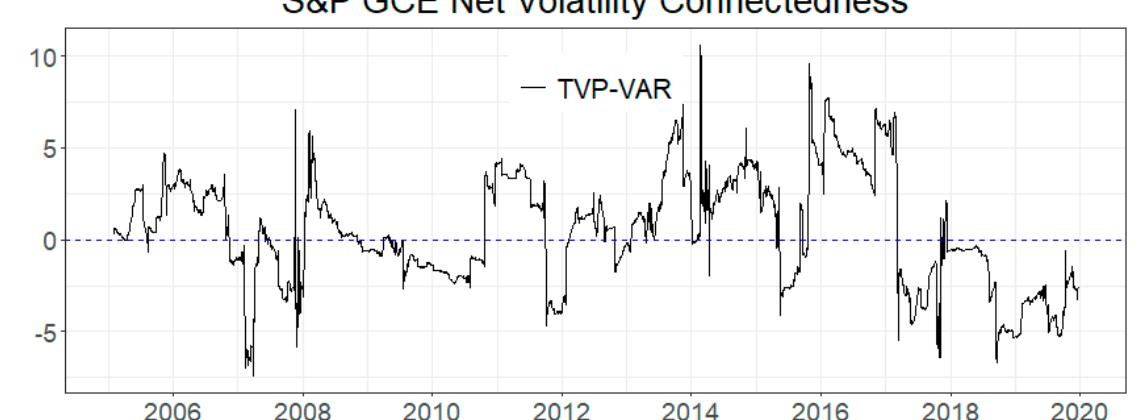
Figure 9. Dynamic net return connectedness. Note: the horizontal axis is the timeline; the vertical axis is the connectedness.